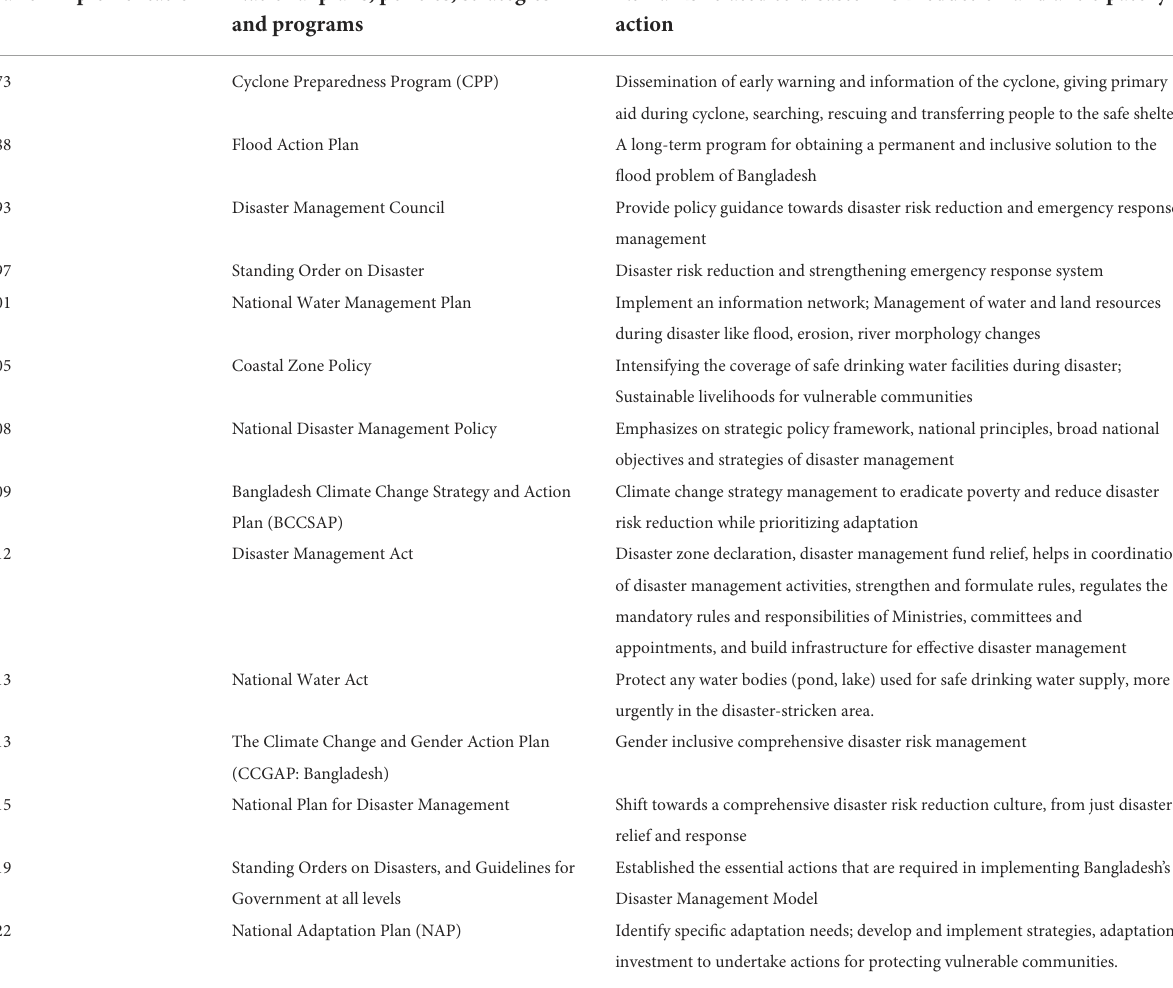
TABLE 1 National plans, policies, strategies and programs related to Disaster Risk